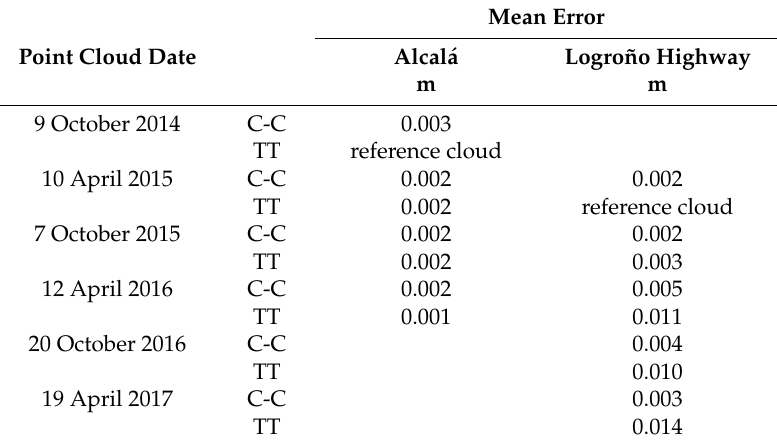
Table 1. Point cloud errors. Cloud-to-cloud registration (C-C); target tension referencing